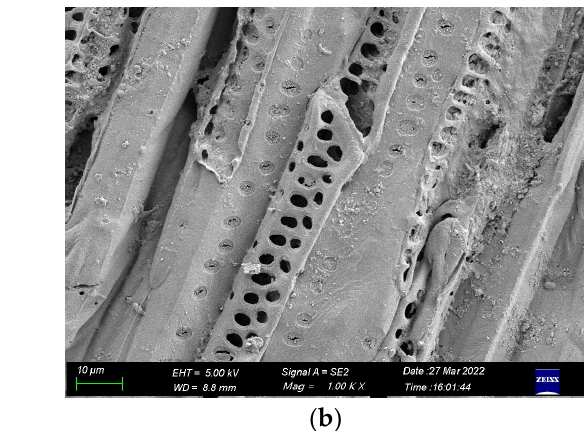
Figure 3. SEM image of the YDF surface before and after pretreatment with NaOH solution: ( a ) untreated YDF; ( b ) treated YDF.